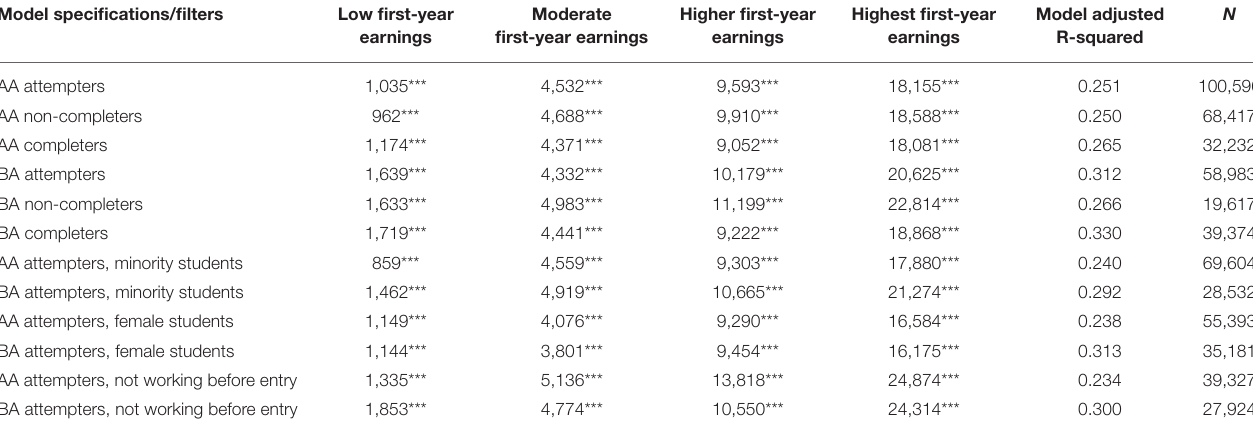
TABLE 5 | Effects of earnings during school on undergraduates’ post-college earnings in dollars ($). Ordinary least squares regressions, subgroup